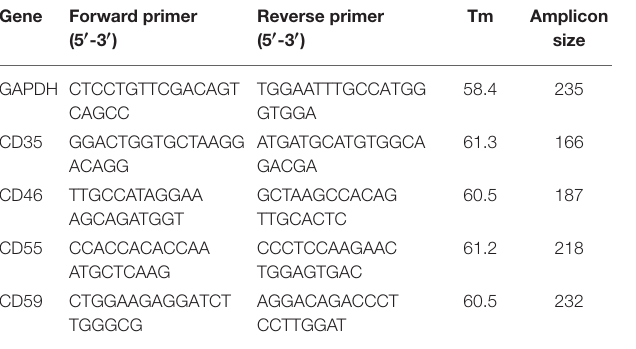
TABLE 1 | Sequence, amplicon size, and melting temperature for each set of primers used for quantitative PCR of CD35, CD46, CD55, and CD59. GAPDH was used as the normalizing gene.